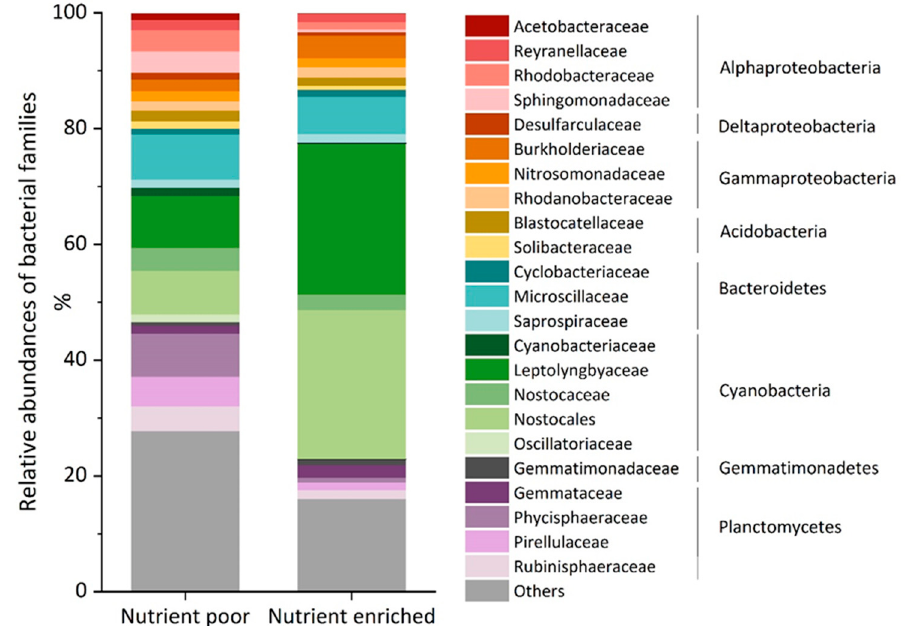
Figure 2. Relative abundance of the main bacterial families in the biofilm samples grown under nutrient poor and nutrient enriched conditions with corresponding phyla and class of Proteobacteria. “Others” contains bacterial families of less than 1% abundance in both samples.